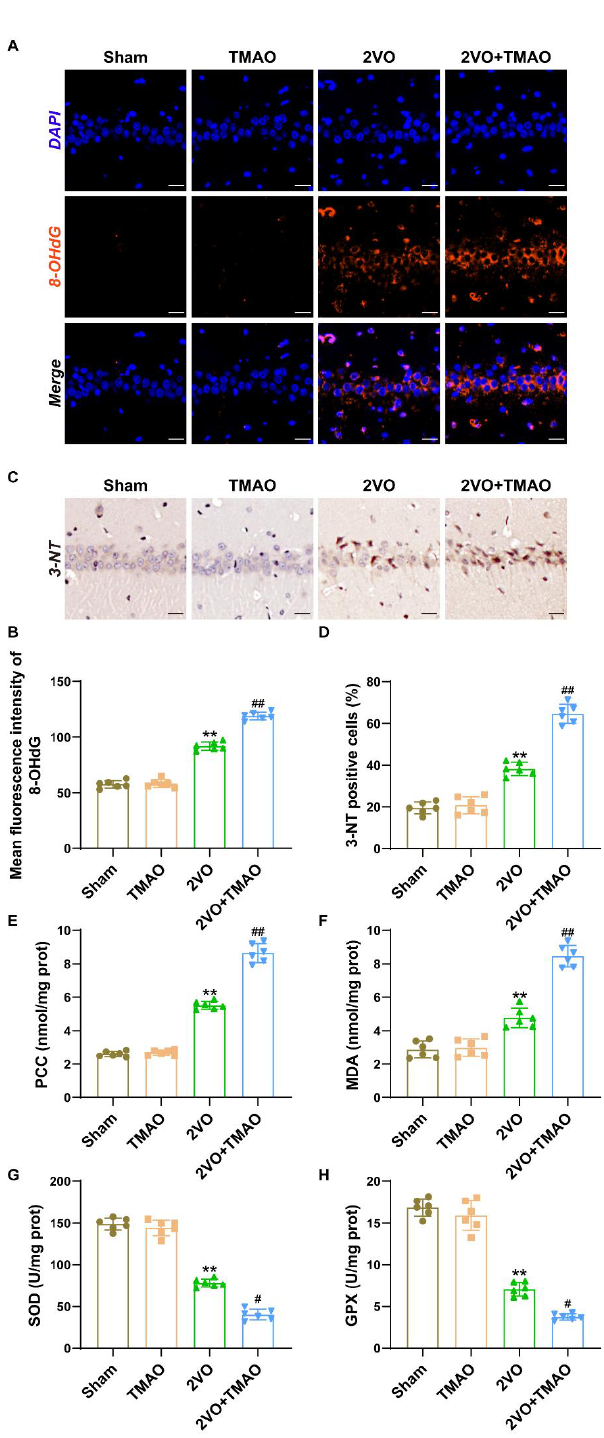
Figure 5. TMAO promoted hippocampal oxidative stress within 2VO rats. ( A ) Representative immunostaining of 8-OHdG (red) within the hippocampal CA1 area. Nuclei were subjected to DAPI staining. Scale bar, 20 µ m (n = 6). ( B ) Quantification of the mean fluorescence intensity of 8-OHdG is shown as a bar chart (n = 6). ( C ) Imaging of the immunohistochemical staining demonstrates 3-NT expression within the hippocampal CA1 area. Scale bar, 20 µ m (n = 6). ( D ) Quantification for 3-NT-positive cells is shown as a bar chart (n = 6). ( E ) PCC and ( F ) MDA levels, and ( G ) SOD and GPX ( H ) activity within the hippocampi of the rats were measured based on the kit manufacturer’s instructions (n = 6). Datasets reflect the mean ± SD. ** p < 0.01 versus the Sham group; # p < 0.05 and ## p < 0.01 versus the 2VO